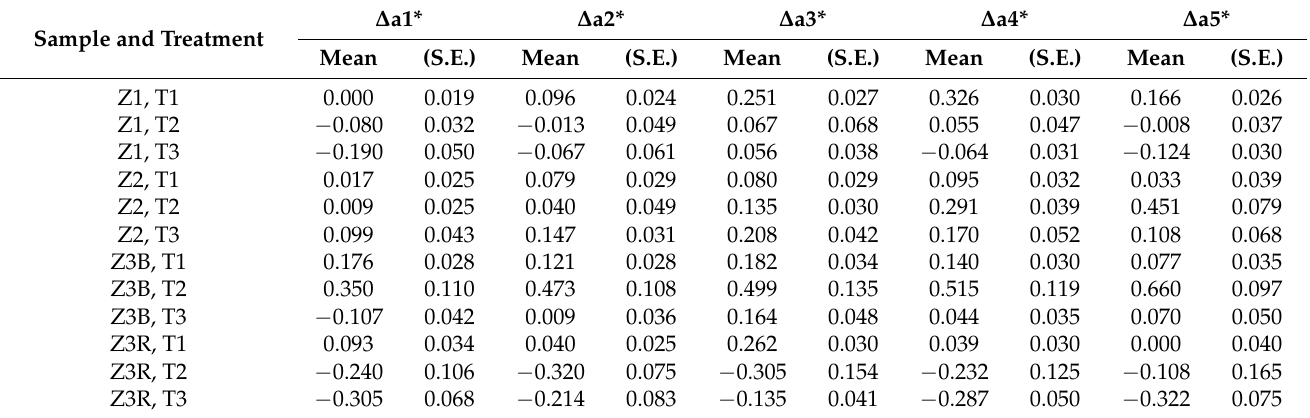
Table 4. Average values for ∆ a* for every ageing treatment cycles.